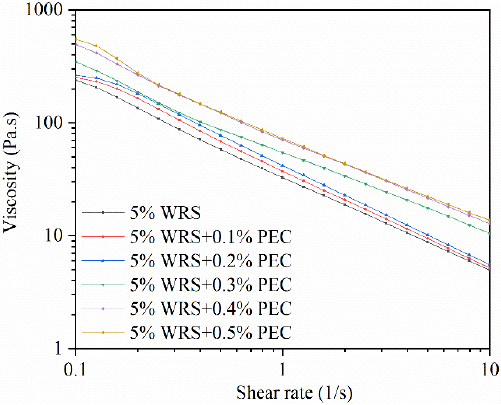
Figure 4. Steady shear of the WRS and the WRS–PEC mixtures.